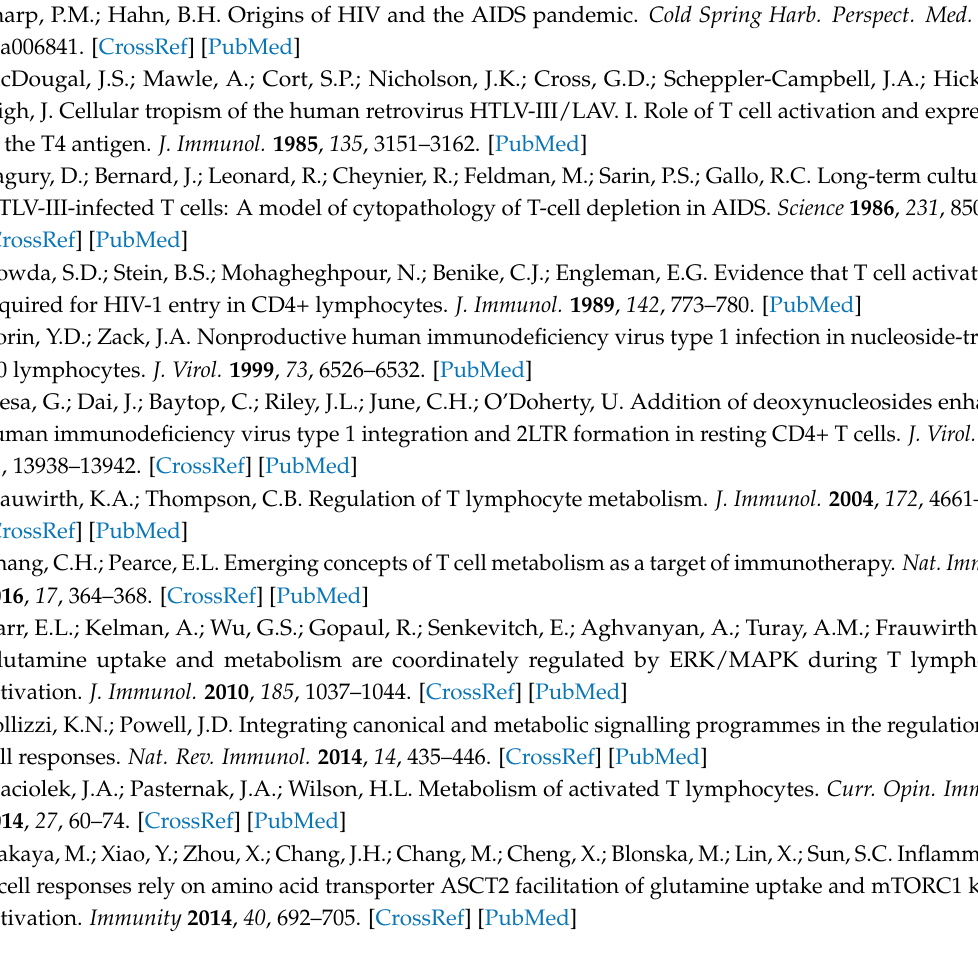
Figure S1. The expression of GLUT proteins in resting versus activated human CD4+ T cells, Figure S2. Expression of GLUT proteins in CD45RA+ and CD45RO+ CD4+ T cells upon activation, Figure S3. Activated human CD4+ Th17 cells show enriched expression of GLUT3, Figure S4. The upregulation of glucose transporters in response to activation of human CD4+ T cells and infection with HIV-1. Figure S5. GLUT inhibitors GTI-2 and WZB117 have additional inhibitory effects on cellular oxygen